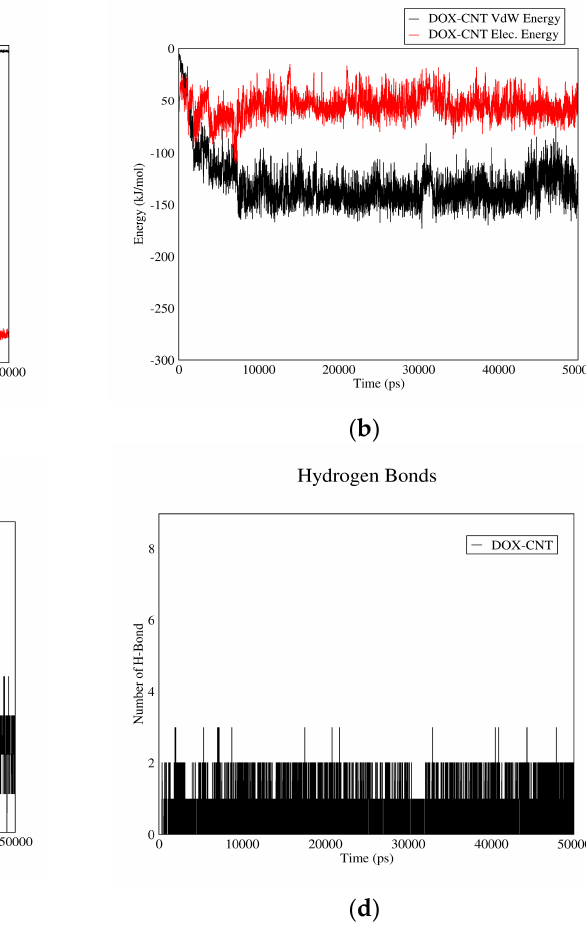
Figure 1. DOX–CNT interaction energies and hydrogen bonds: ( a ) electrostatic and Van der Waals energies of DOX–CNT interaction versus time in neutral pH; ( b ) electrostatic and Van der Waals energies of DOX–CNT interaction versus time in acidic pH; ( c ) the number of hydrogen bonds between DOX and CNT versus time in neutral pH; ( d ) the number of hydrogen bonds between DOX and CNT versus time in acidic pH.